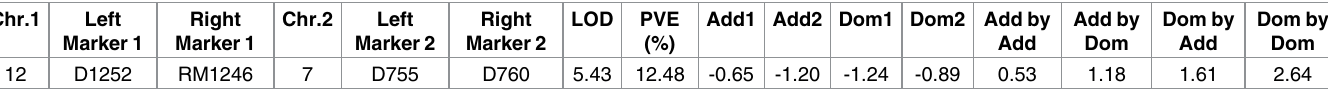
the second digenic locus. Dom1: estimated dominance effect of the first digenic locus. Dom2: estimated dominance effect of the second digenic locus. Add by Add: additive-by-additive digenic interaction. Add by Dom: additive-by-dominance digenic interaction. Dom by Add: dominance-by-additive digenic interaction. Dom by Dom: dominance-by-dominance digenic